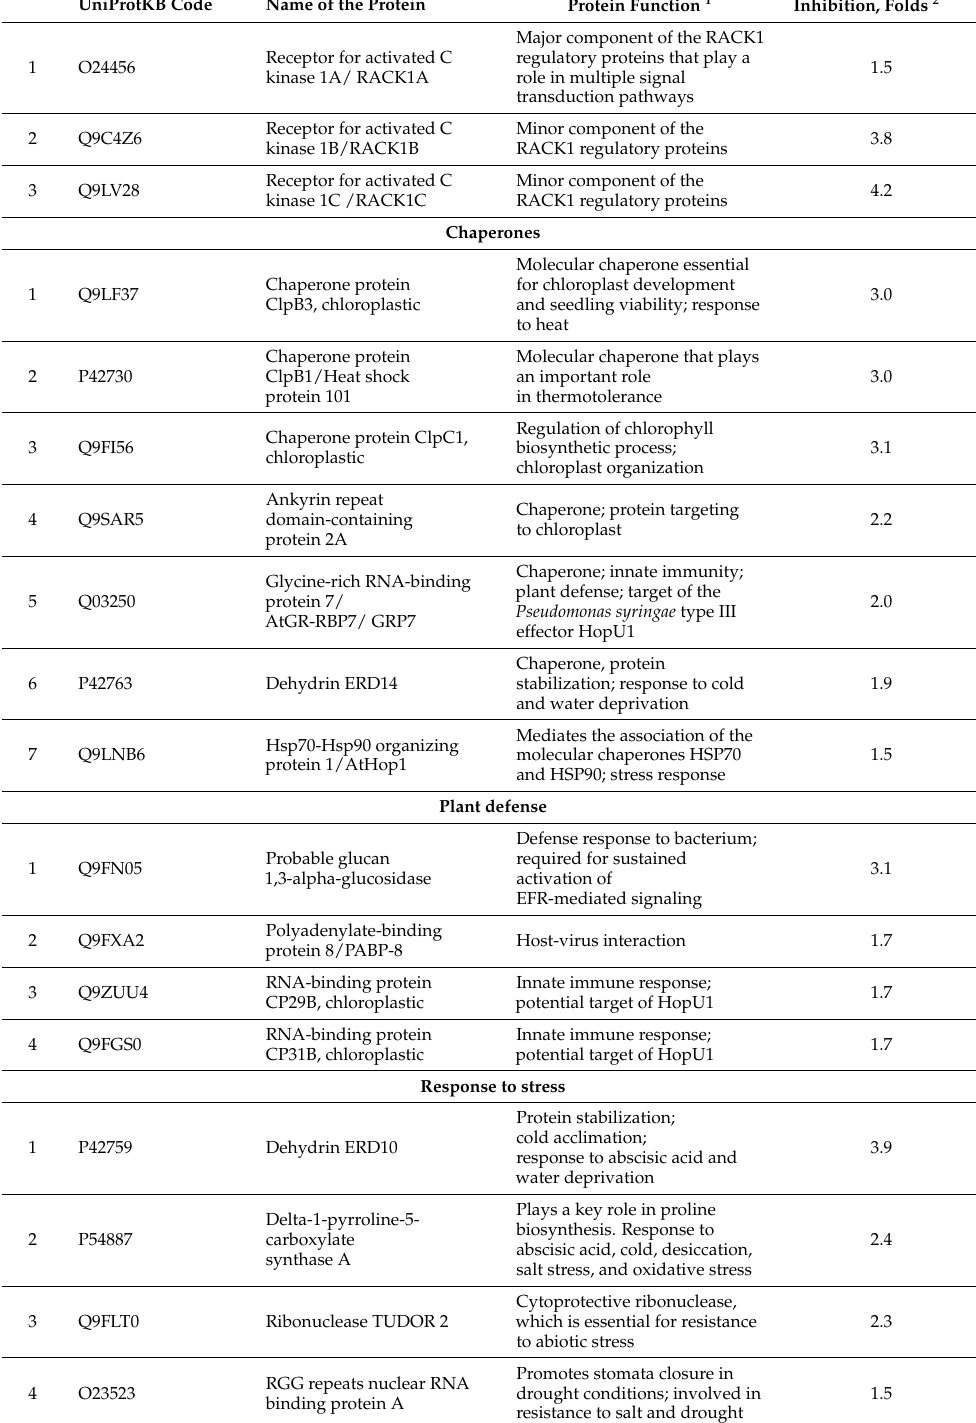
Table 2. Proteins downregulated in rolB -expressing Arabidopsis